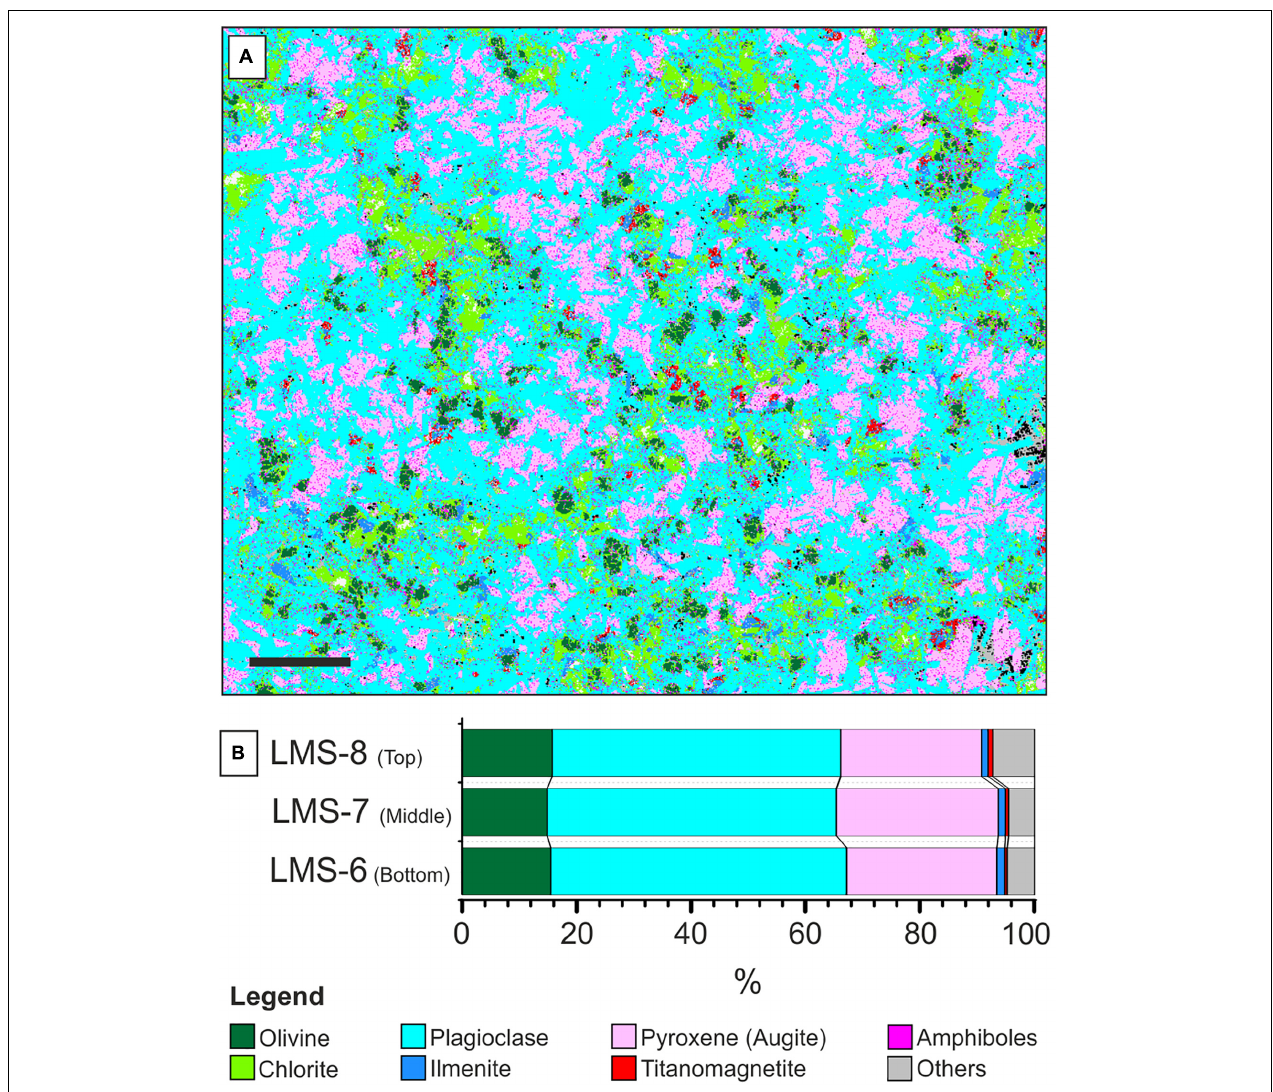
FIGURE 8 | (A) QEMSCAN image of thin section LMS-6 collected from the bottom of the crinanite. Black scale bar in the bottom left corner of is 2 mm in length. (B) The modal abundances of mineral phases in samples collected from close to the Top (LMS-8), Middle (LMS-7), and Bottom (LMS-6) of the sill, estimated by QEMSCAN (see Table 2 ). Note that in (B) green represents the sum of olivine and chlorite, as chlorite is interpreted to be altered olivine, and pink represents the sum of pyroxene and amphibole, as amphibole is interpreted to be altered